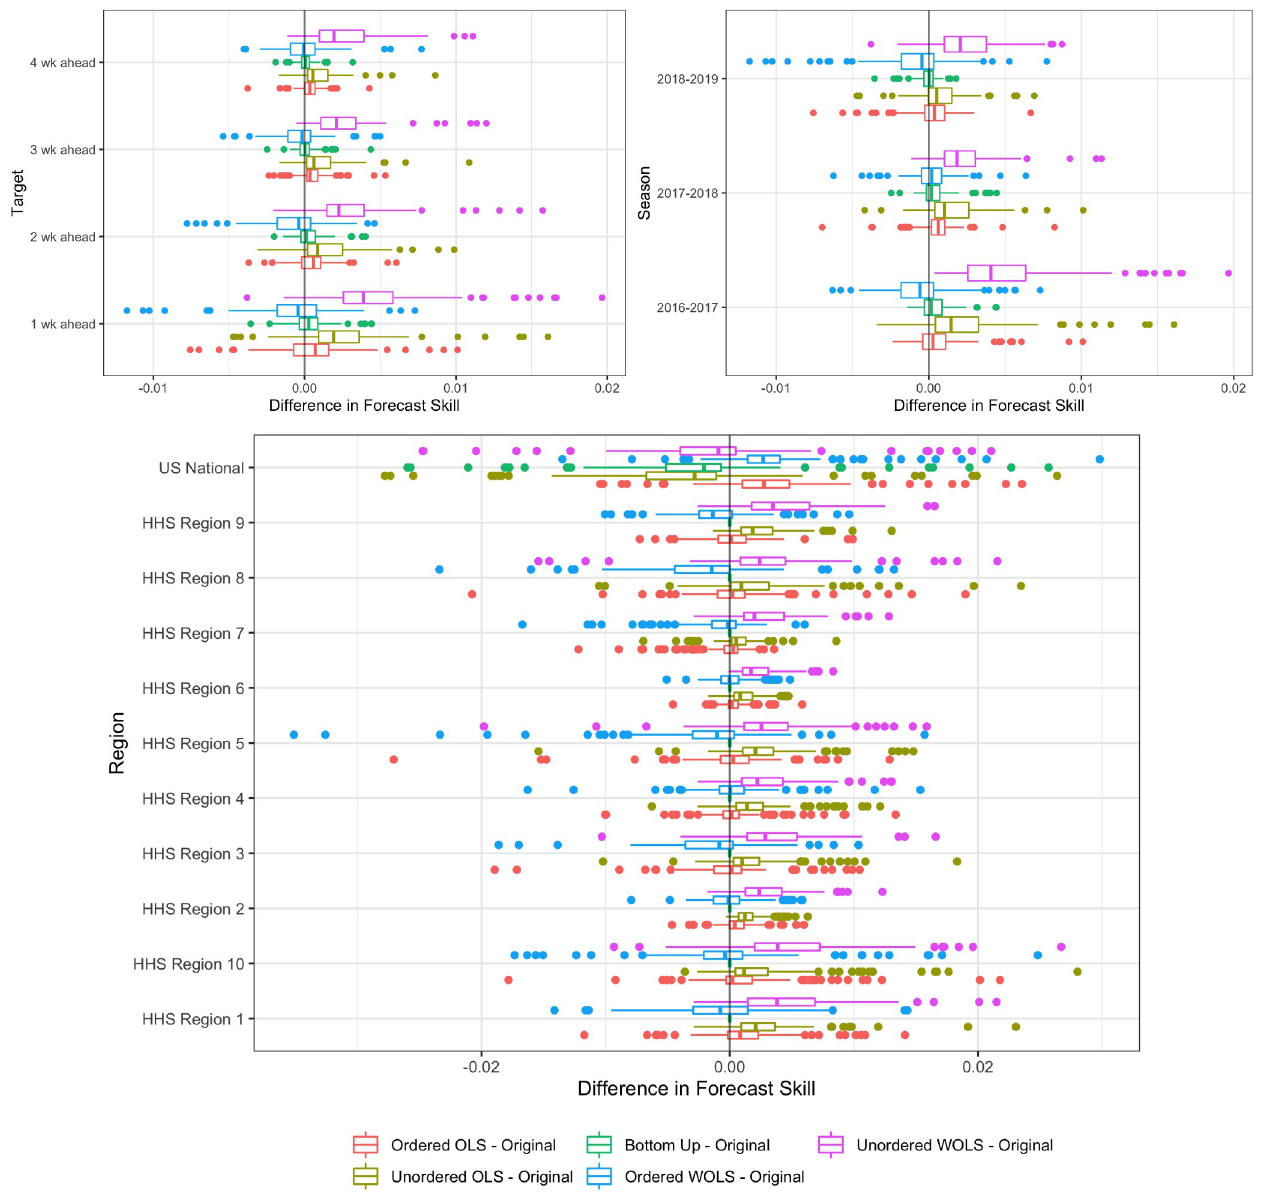
Fig 8. Difference between single-bin forecast skill of projection method and forecast skill of independent forecasts averaged over all regions and epiweeks broken down by target (left), season (right), and region (bottom). Each point represents a single model-season combination. Box-whisker forecasts and represent the inter-quartile range as well as the maximum and minimum in forecast skill difference between projected method and independent forecasts. The improvements in single-bin forecast skill are consistent across season and target for the unordered WOLS. However, the improvements are only consistent across the HHS regions, not the national